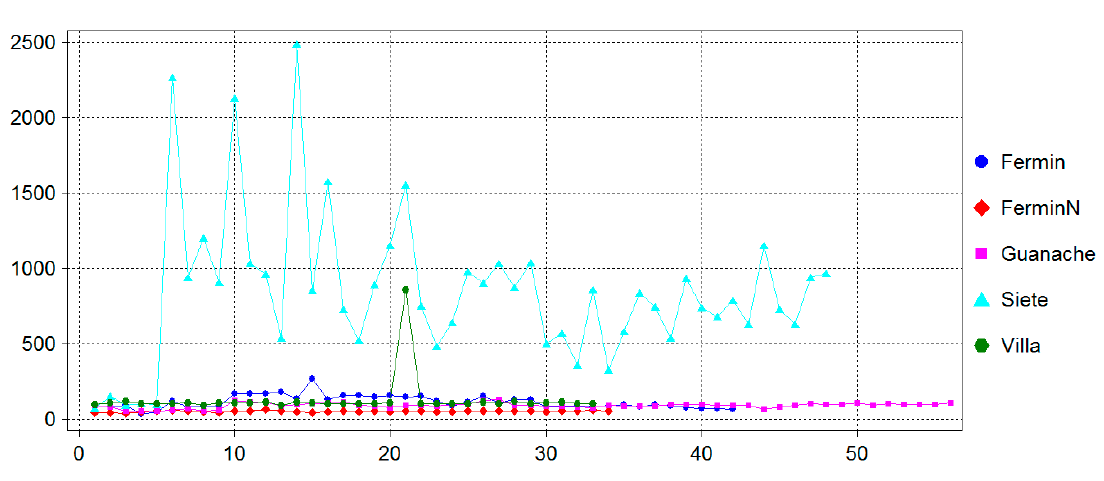
Figure 9. Downstream longitudinal sequence plot of the pollution load index values.